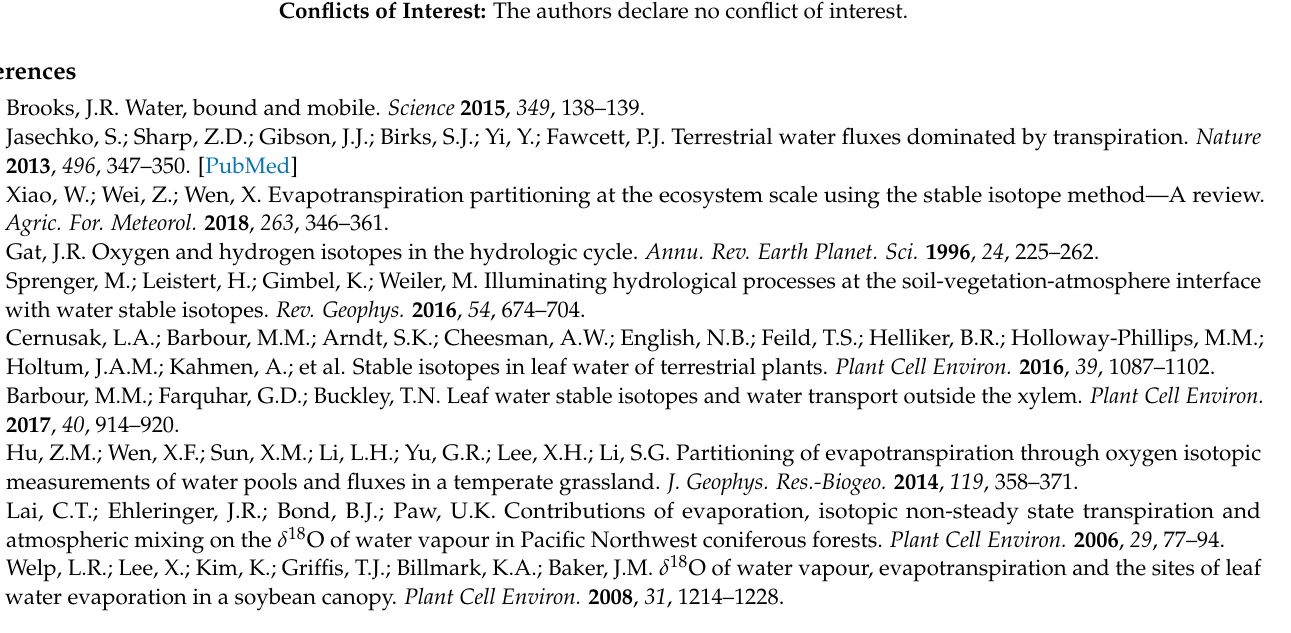
27 m; Figure S3: Diurnal patterns of (a) transpiration δ 18 O via non-steady ( δ 18 O TDG and δ 18 O TFC ), (b) transpiration δ 18 O via steady-state ( δ 18 O TSS ), evaporation δ 18 O ( δ 18 O E ), evapotranspiration δ 18 O ( δ 18 O ET ), and water vapor δ 18 O ( δ 18 O v ), and (c) transpiration, evaporation and evapotranspiration flux; Table S1: Mean, minimum and maximum values, and standard deviation (SD) of δ 18 O in xylem and leaf water of C. lanceolata , P. massoniana , and P. elliottii , and soil water at 0–5, 15–20 and 40–45 cm depths, and water vapor at heights of 17 and 27 m; Table S2: Correlation factor (R) among δ 18 O of xylem (XW) and leaf (LW) water of C. lanceolata (C.L.), P. massoniana (P.M.), and P. elliottii (P.E.), and soil water at 0–5 (SW 0–5), 15–20 (SW 15–20) and 40–45 (SW 40–45) cm depths, and water vapor at heights of 17 (WV 17) and 27 (WV 27)